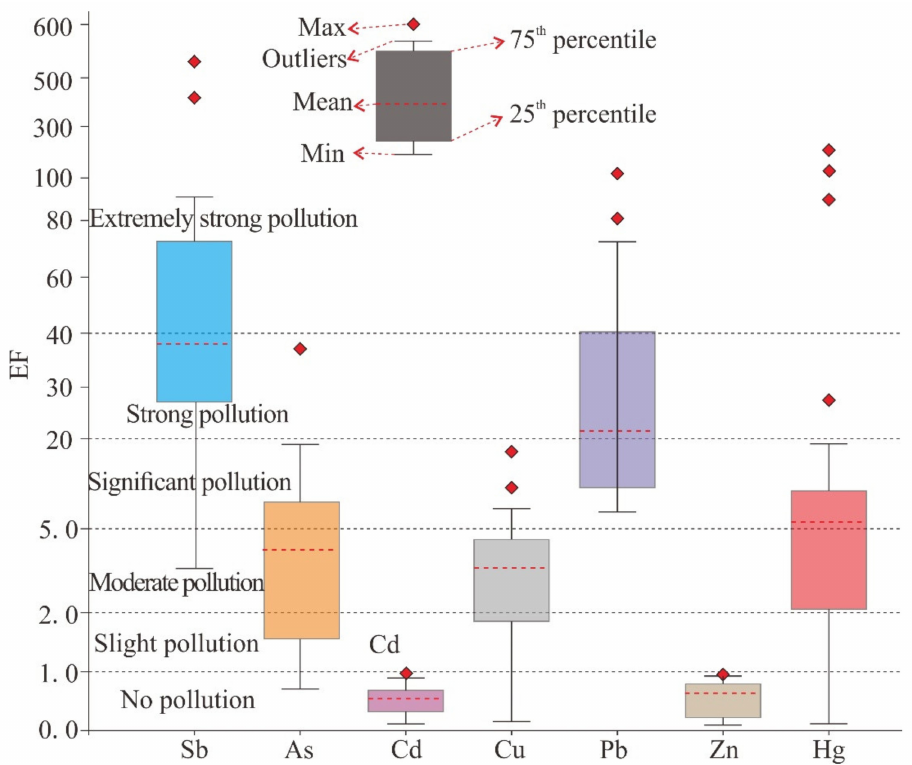
Figure 4. Whisker-box plots for enrichment factors (EFs) and pollution grades of the studied PTEs in